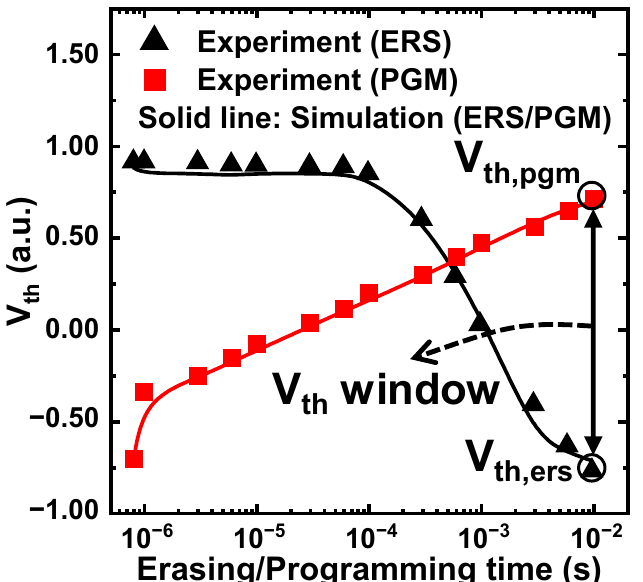
Figure 3. V th vs. operating time started from different ERS/PGM states during a single pulse operation. The simulation (solid line) and the experimental (symbol) data are in good agreement. The V th window is the sum of | V th,ers | and V th,pgm at time = 10 − 2 s.